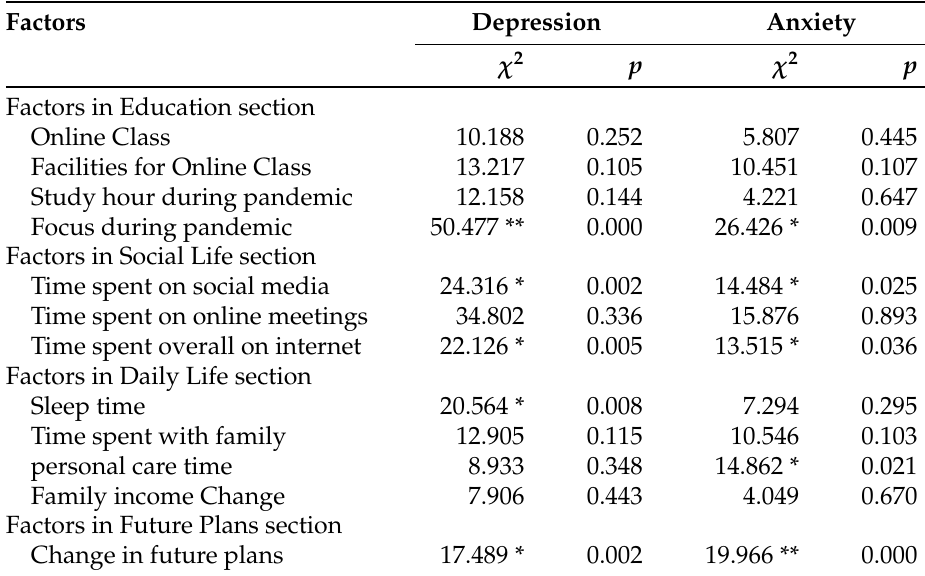
Table 2. Dependency analysis using chi-square test (N = 409). Here, p < 0.05 is considered as significant * and p < 0.001 is considered as highly significant